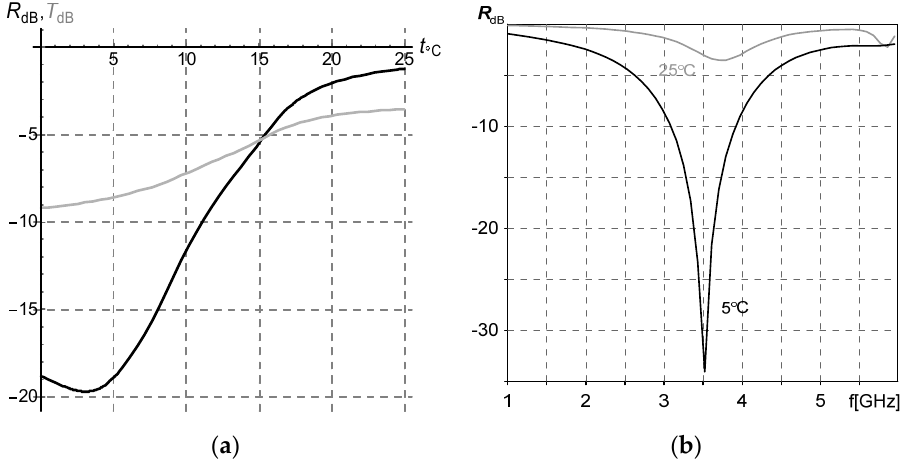
Figure 7. ( a ) Simulated dependence of reflection and transmission coefficients on temperature at f = 3.5 GHz. ( b ) Frequency dependence of reflection coefficient for shorted sample measured at 5 ° С and 25 ° С .